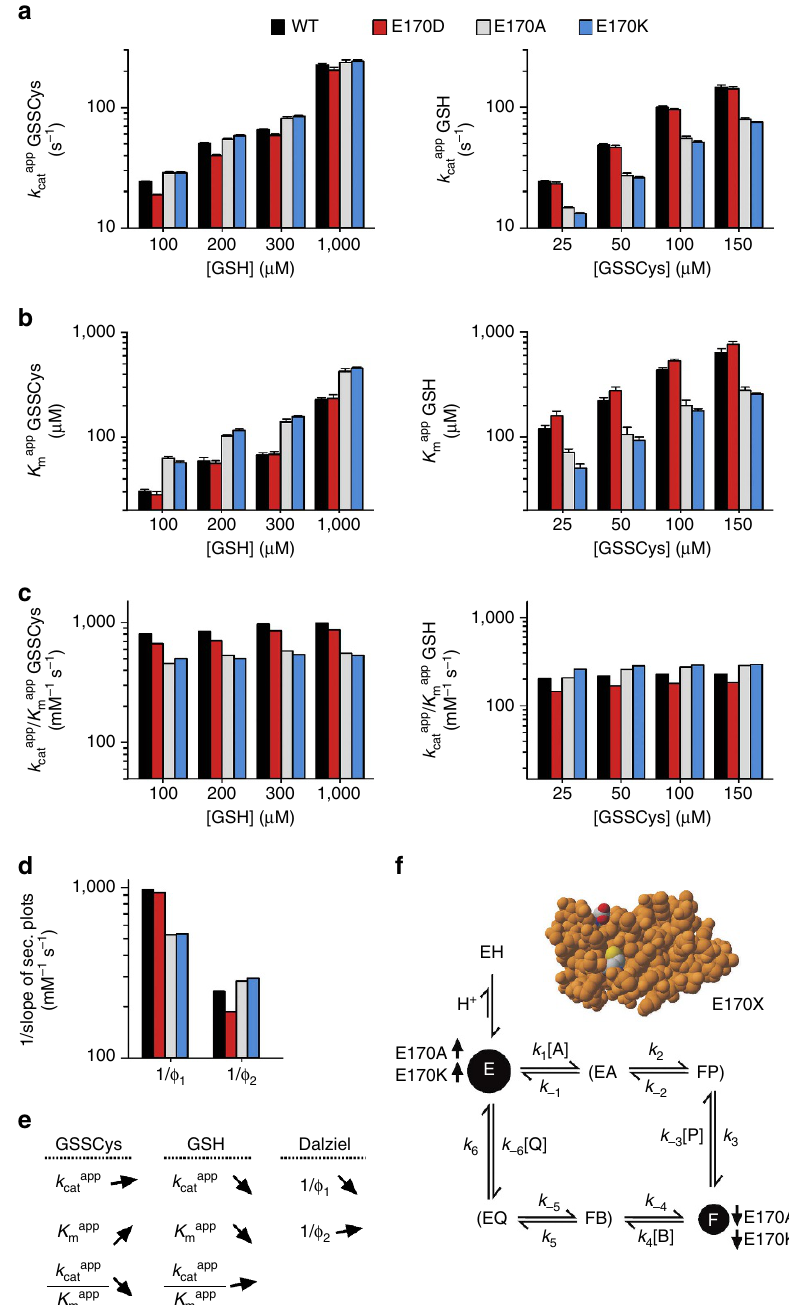
Figure 4 | Replacement of Glu170 decelerates the oxidative half-reaction of the GSSCys assay. ( a , b ) Selected k cat app and K m app values of ScGrx7 wild-type enzyme and E170X mutants for GSSCys and GSH. ( c ) Calculated catalytic efficiencies from a and b . ( d ) Reciprocal Dalziel coefficients, which probably reflect the rate constants of the oxidative and reductive half-reaction with GSSCys and GSH, respectively. ( e ) Summary of the altered kinetic parameters for E170A/K. ( f ) Data interpretation based on a general ping-pong mechanism. Altered concentrations of the active free enzyme ‘E’ (thiolate form) and glutathionylated enzyme ‘F’ upon mutation of Glu170 are highlighted. GSSCys and GSH correspond to substrates A and B, respectively. Cysteine and GSSG correspond to products P and Q, respectively. Original plots and kinetic parameters for a – c are shown in Supplementary Fig. 6 and Supplementary Table 4 and are the mean ± s.d. from at least three independent replicates. Statistical analyses and P -values for the k cat app and K m app values from a and b are listed in Supplementary Table 11. Reciprocal Dalziel coefficients for d were obtained from Supplementary Fig. 7 and are listed together with the true k cat values in Supplementary Table